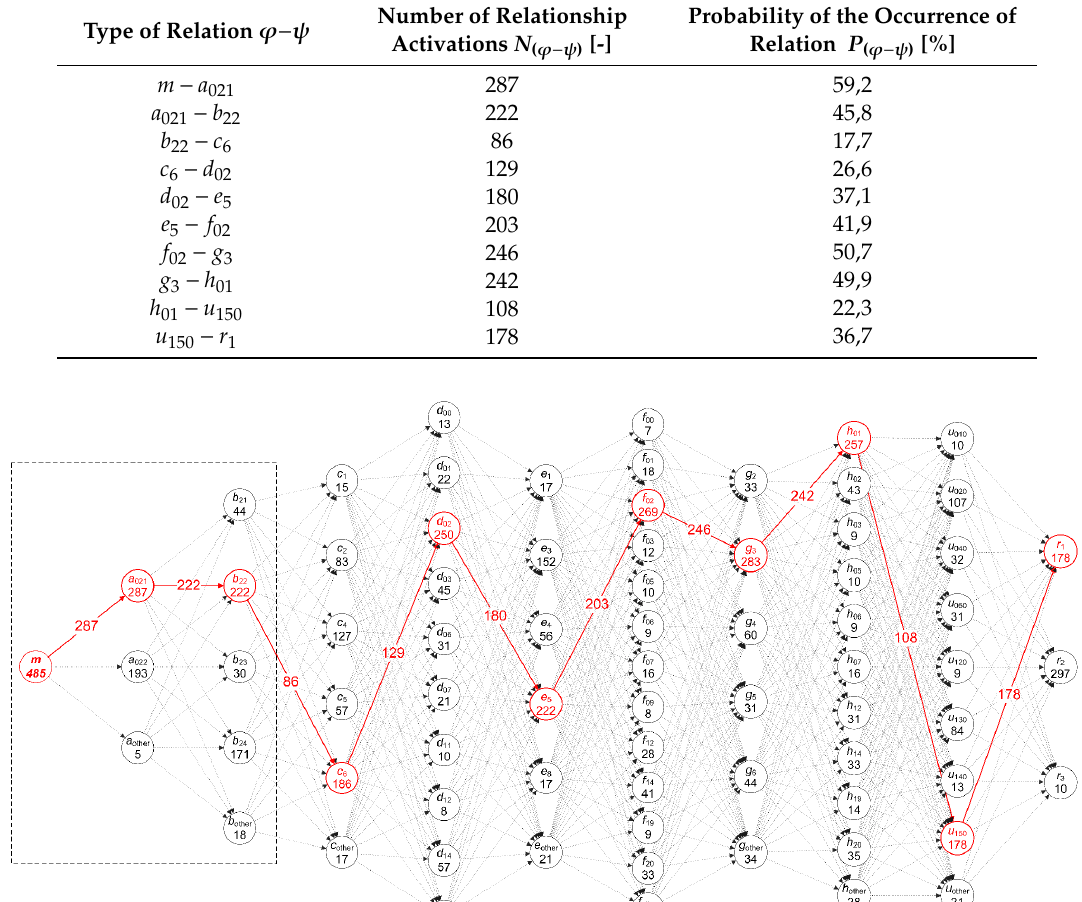
Table 4. Summary of relations connecting neighboring nodes that are characterized with the largest number of activations and lying on the critical path. number of activations and lying on the critical path.